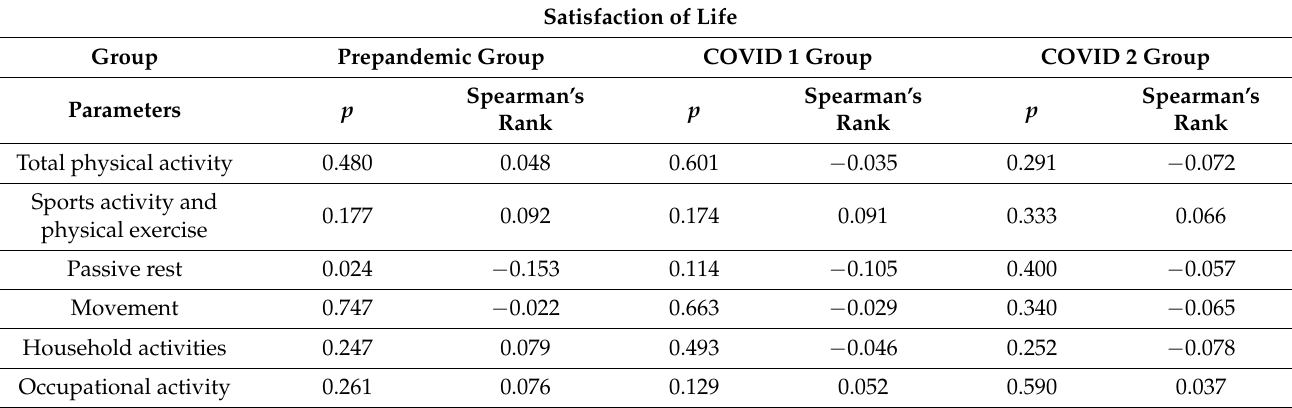
Table 6. Spearman’s Rank Correlations—Physical Activity and Life